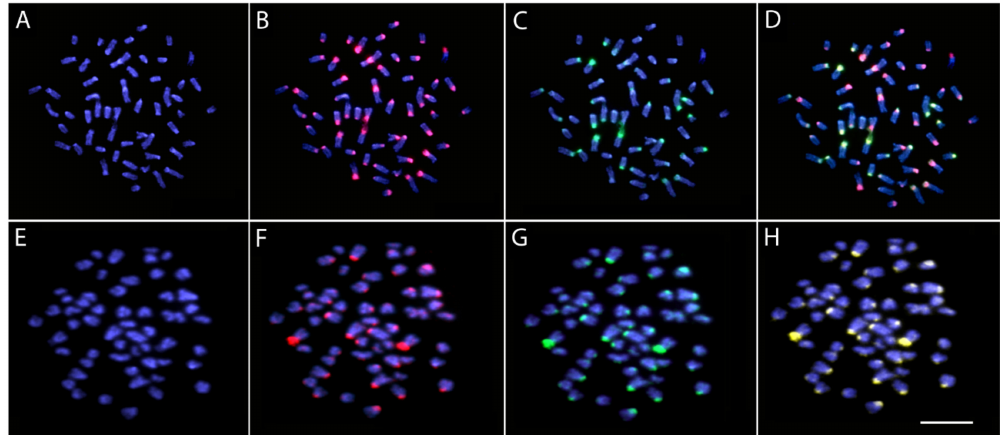
Figure 3. Comparative genomic hybridization (CGH) for intra- and interspecific comparison in chromosomes of Osteoglossum ferreirai ( A – D ) and Osteoglossum bicirrhosum (AMb population) ( E – H ). Genomic probes from both O. ferreirai and O. bicirrhosum hybridized together on background chromosomes of O. ferreirai ( A – D ) and genomic probes from O. bicirrhosum (TAb population) and (AMb population) hybridized together onto background chromosomes of O. bicirrhosum (TAb population) ( E – H ). First column ( A , E ): DAPI images (blue); second column ( B , F ): hybridization pattern using gDNA of O. ferreirai ( B ) and gDNA of O. bicirrhosum (TAb population) probes (red); third column ( C , G ): hybridization pattern using gDNA of O. bicirrhosum (AMb population) probes (green); fourth column ( D , H ): merged images of both genomic probes and DAPI staining. The common genomic regions are depicted in yellow. Bar = 5 µ